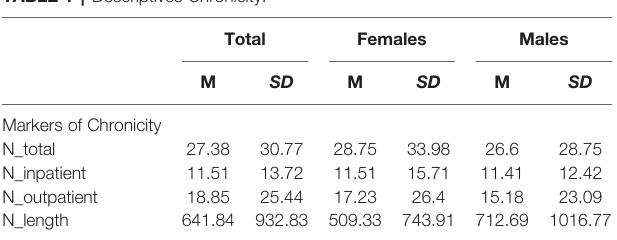
TABLE 1 | Descriptives Chronicity. TABLE 2 | Association of GRPS With